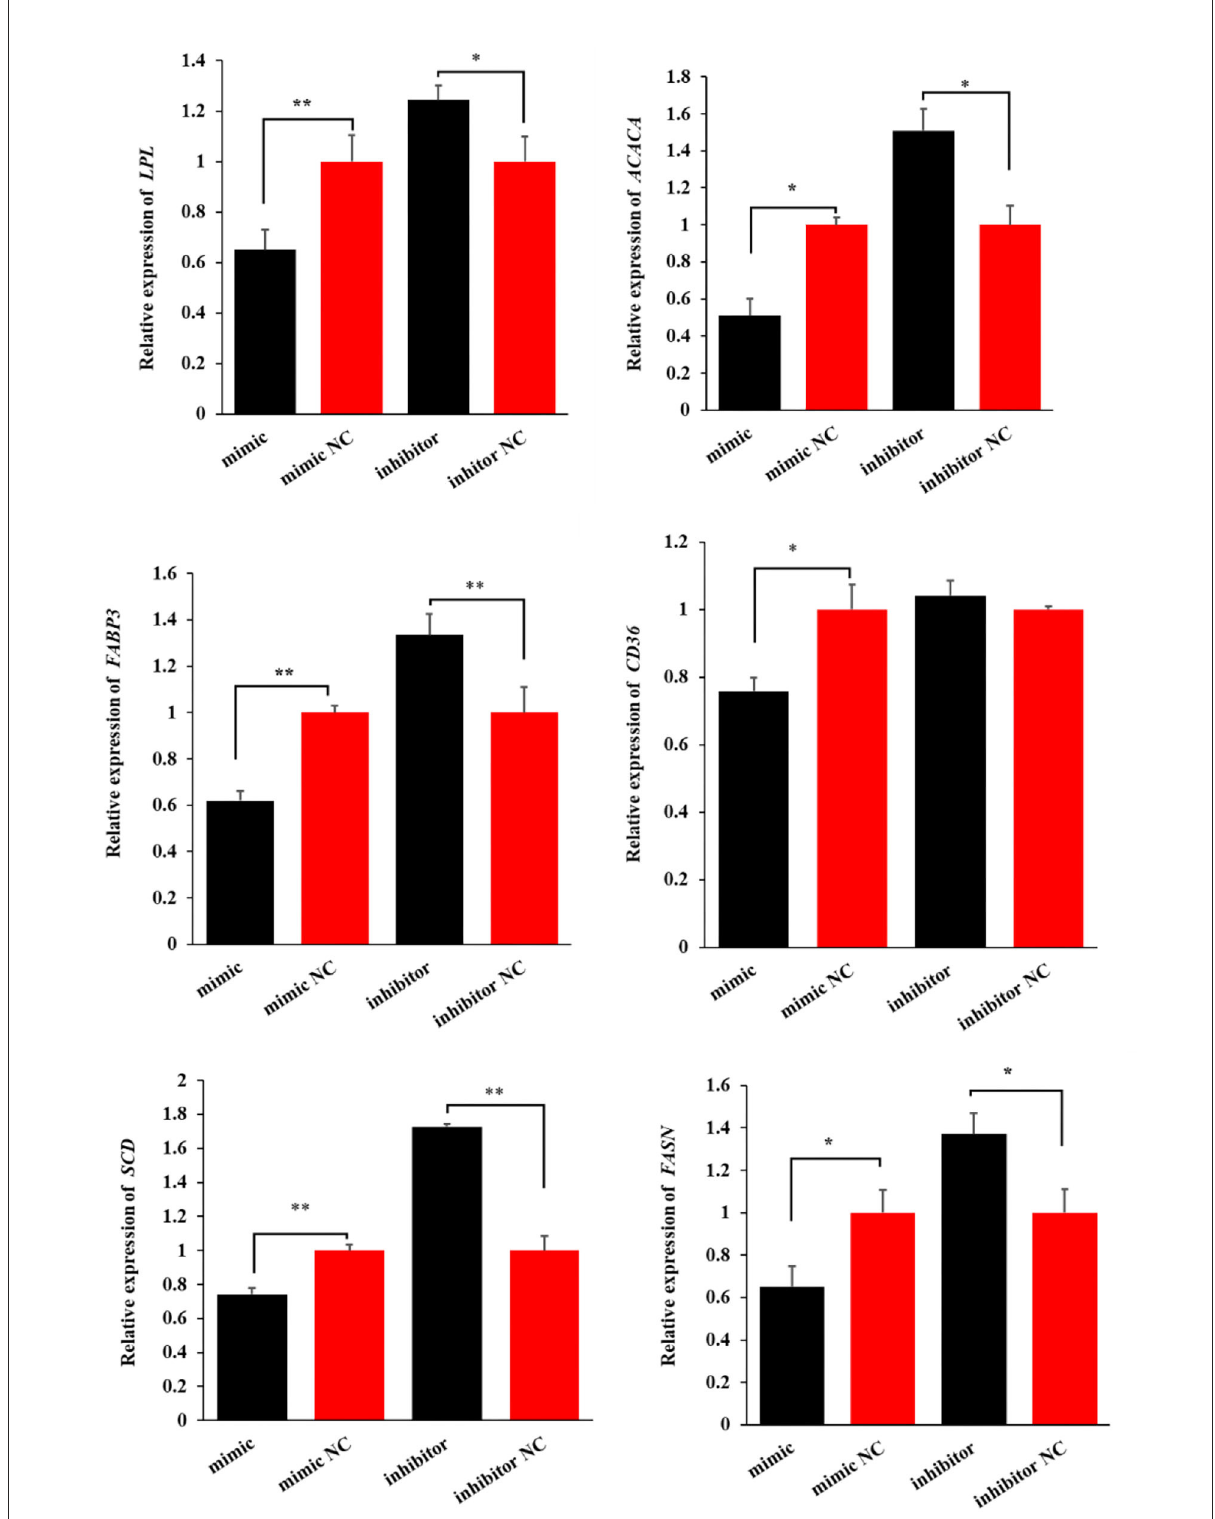
FIGURE5 The expression levels of six milk fat synthesis marker genes, namely, LPL , ACACA , FABP3 , CD36 , SCD, and FASN, when the miR-199a-3p mimic and miR-199a-3p inhibitor were transfected into ovine mammary epithelial cells (OMECs). ** P < 0.01 and * P < 0.05.